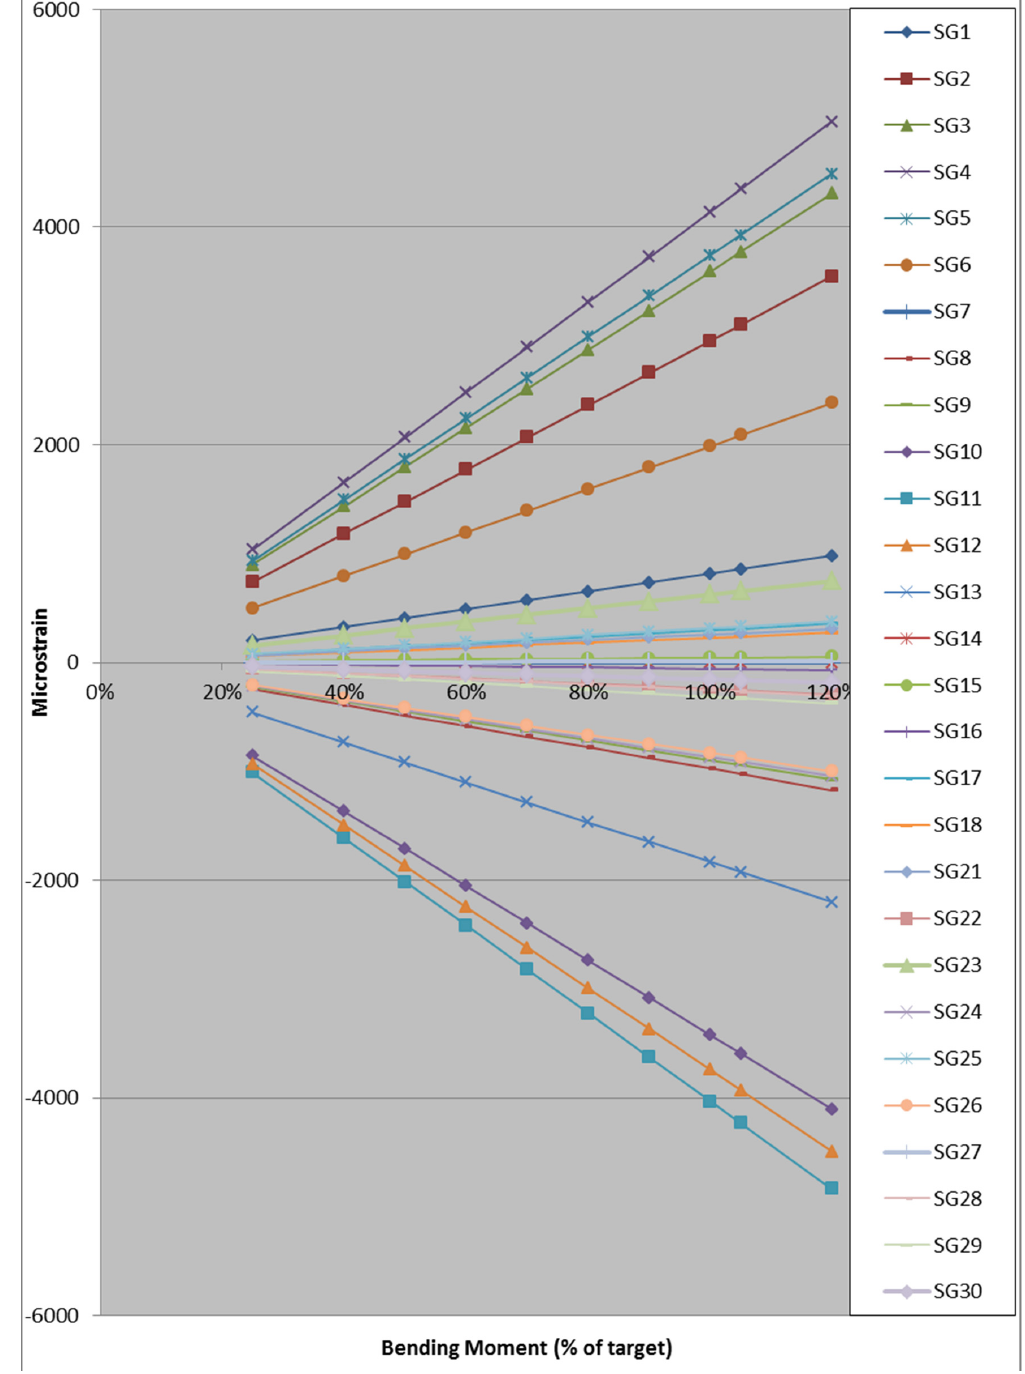
Figure 4. Variation of strains and root bending moment as % of estimated target BM along the as received blade.